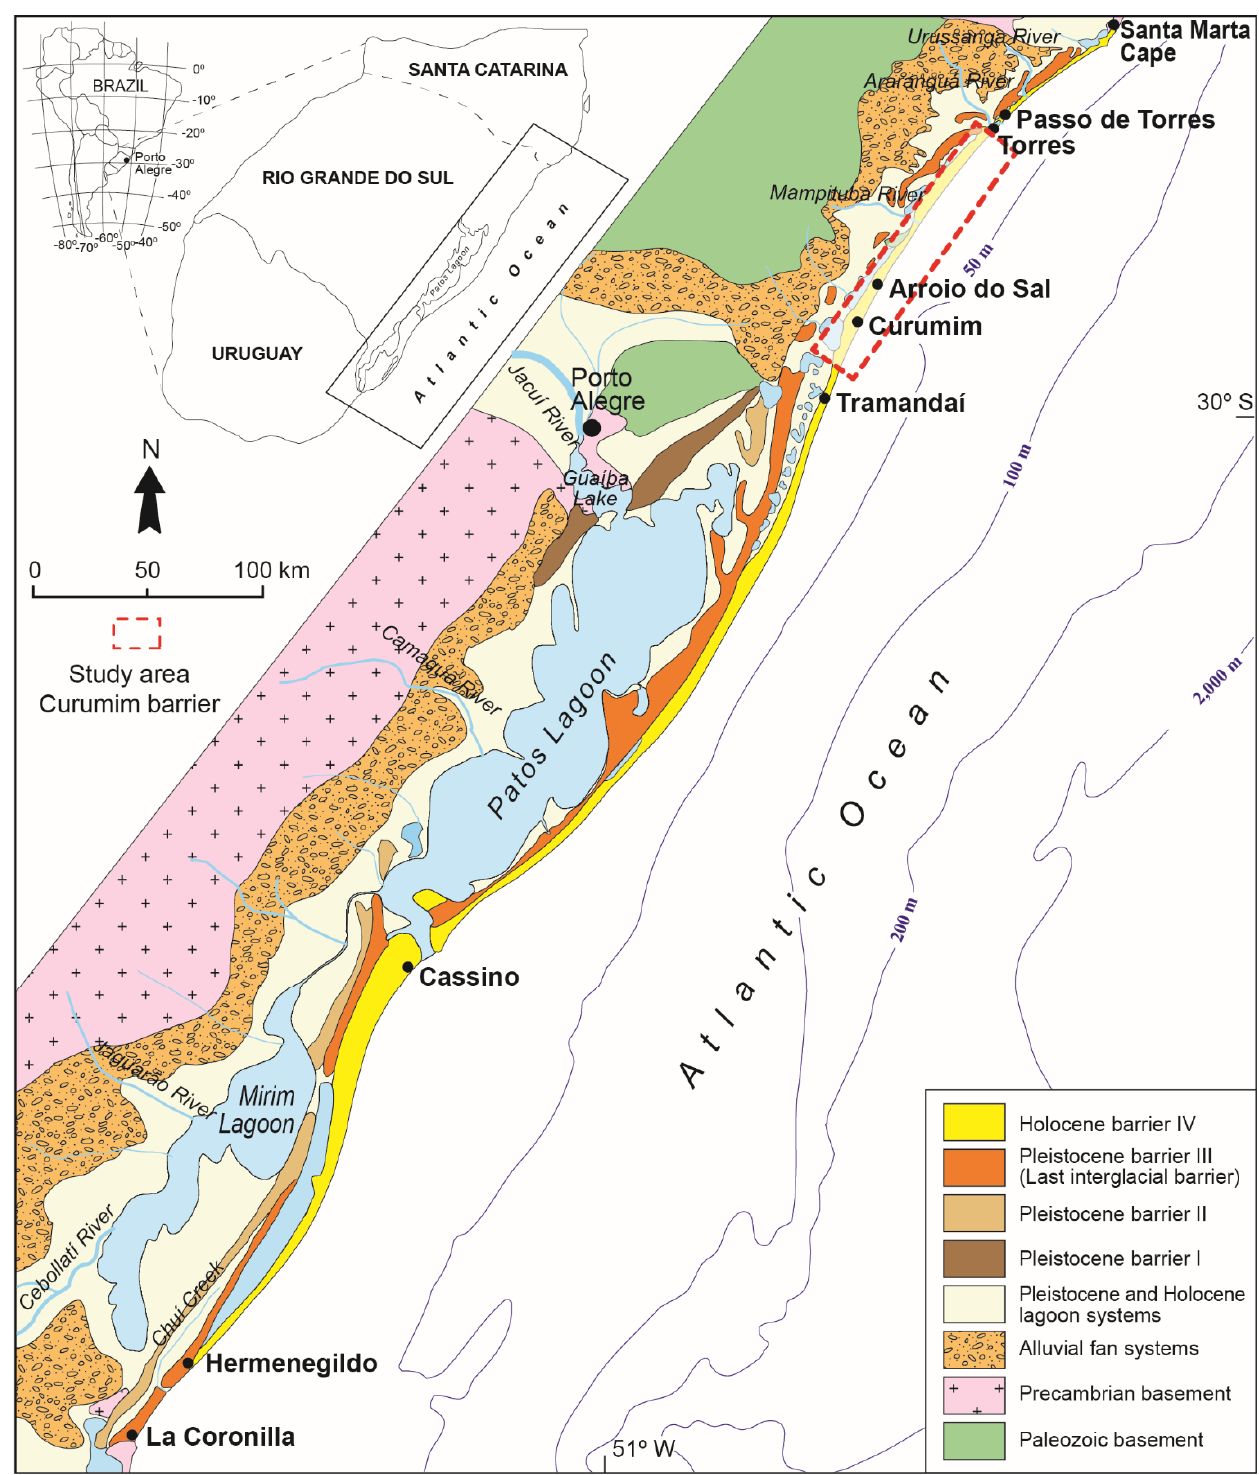
Figure 1. Location of the Curumim barrier study area (dashed red rectangle) showing the general geology of the coastal plain of southern Brazil–datum WGS84 (modified after [15]).